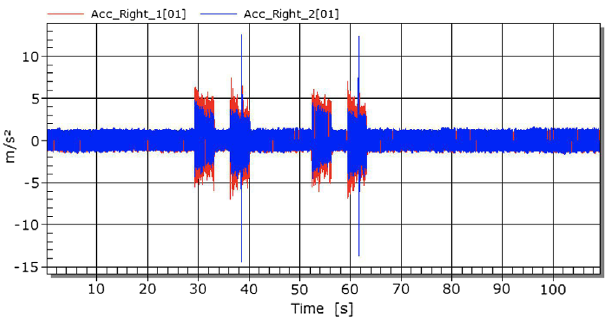
FIG. 19. Accelerometer measurements during a right jaw rotation. A click is detected if the reading exceeds a certain threshold, e.g., 8 ms − 2 .